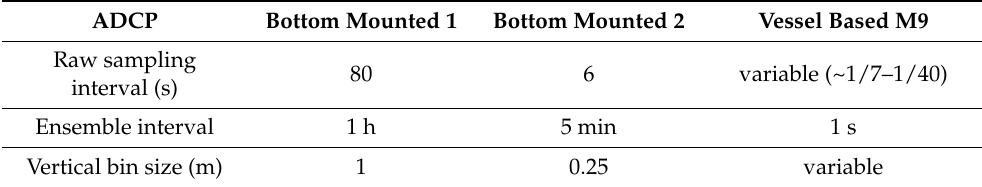
Table 1. ADCP parameters. ADCP Bottom Mounted 1 Bottom Mounted 2 Vessel Based M9 Raw